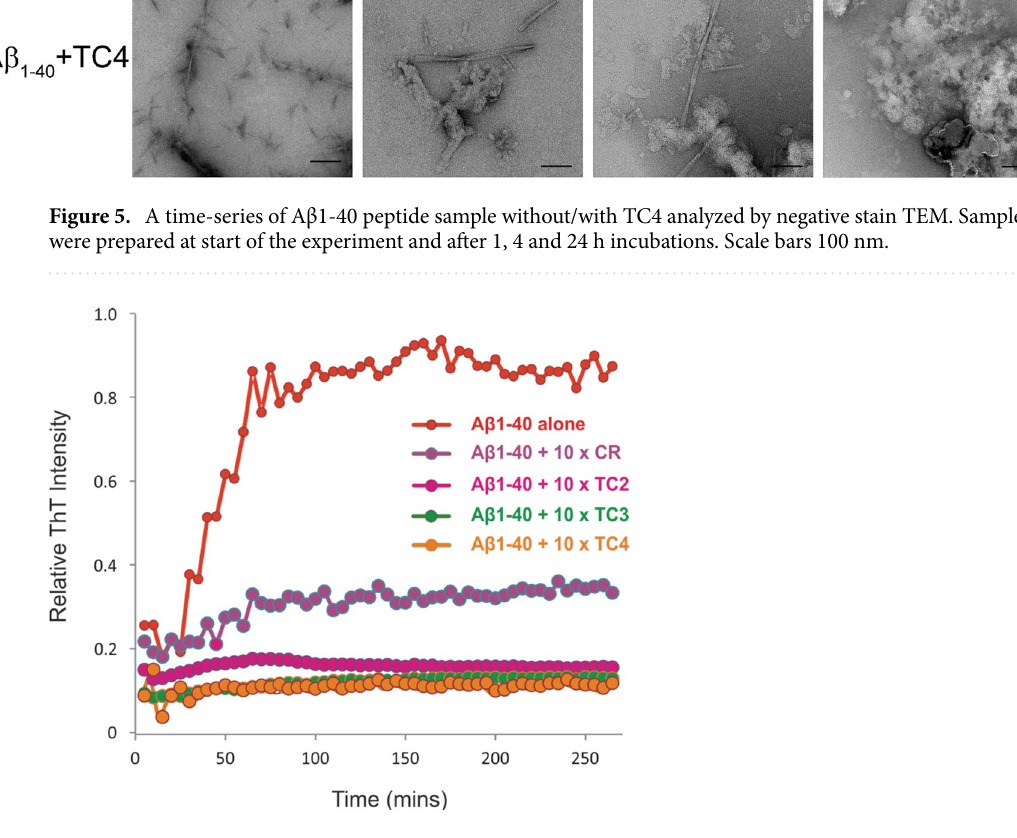
Figure 6. Inhibition of the Aβ amyloid assembly by Crocins. ThT fluorescence intensity over time of Aβ peptide alone (red circles) (32 μM peptide in water, pH 5.8, 25 °C, quiescent) and in the presence of the isolated crocin components containing 0–4 carbohydrate moieties, i.e., CR (purple), TC2 (cyan), TC3 (green) and TC4 (orange) at 10:1 molar